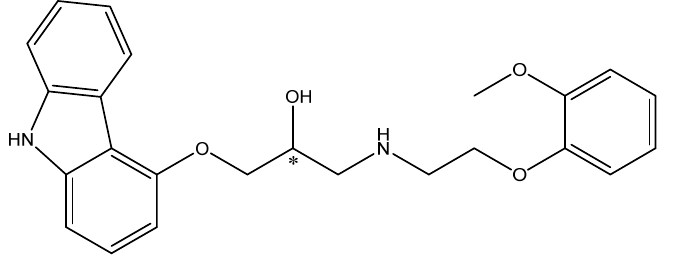
Figure 3. Structure of racemic felodipine.